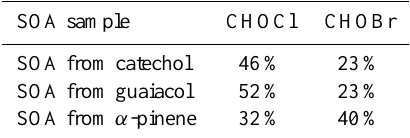
Table 3. Relative amount of halogenated compounds (compared to the not halogenated bulk) observed by ICR-FT/MS in samples of SOA interacting with RHS released from the simulated salt-pan. SOA sample CHOCl CHOBr SOA from catechol 46% SOA from guaiacol SOA from α